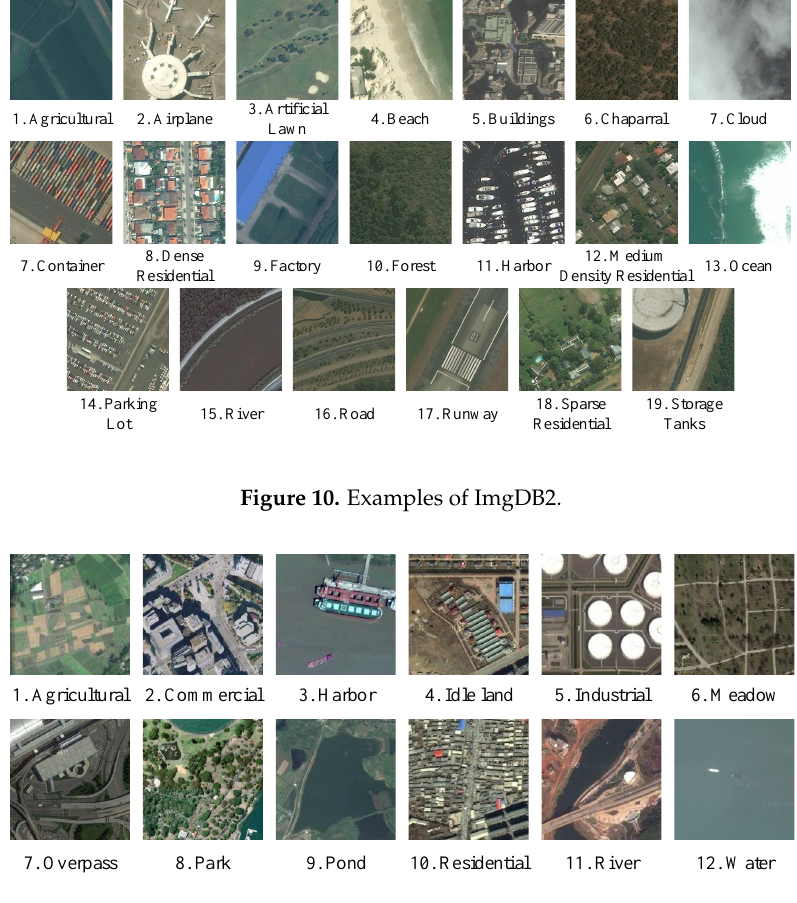
Figure 11. Examples of ImgDB3.